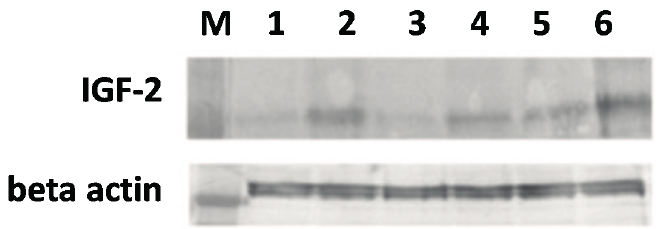
Figure 4. Western blot analysis of IGF-2 protein in the SW620 human colon adenocarcinoma cell line. Cells were exposed to 3 mM 5-ALA or met-ALA and additionally treated with light (4.5 J/cm 2 ) or not irradiated. Differences between samples were found: Lane 1 shows the band from control cells without treatment; Lane 2 from cells treated with light only; Lanes 3 and 5 from cells incubated with 5-ALA or met-ALA, respectively; Lanes 4 and 6 from cells treated with PDT at the above doses. An increase in IGF-2 was also observed in cells treated with light only (Lane 2) and photosensitizer precursors without light irradiation (Lanes 3 and 5). M, Marker mass.